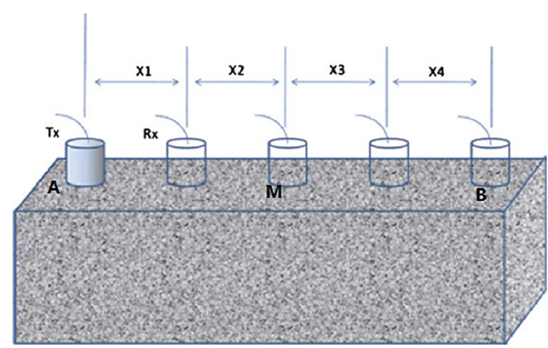
Figure 7. Schematic view of Indirect UPV test.